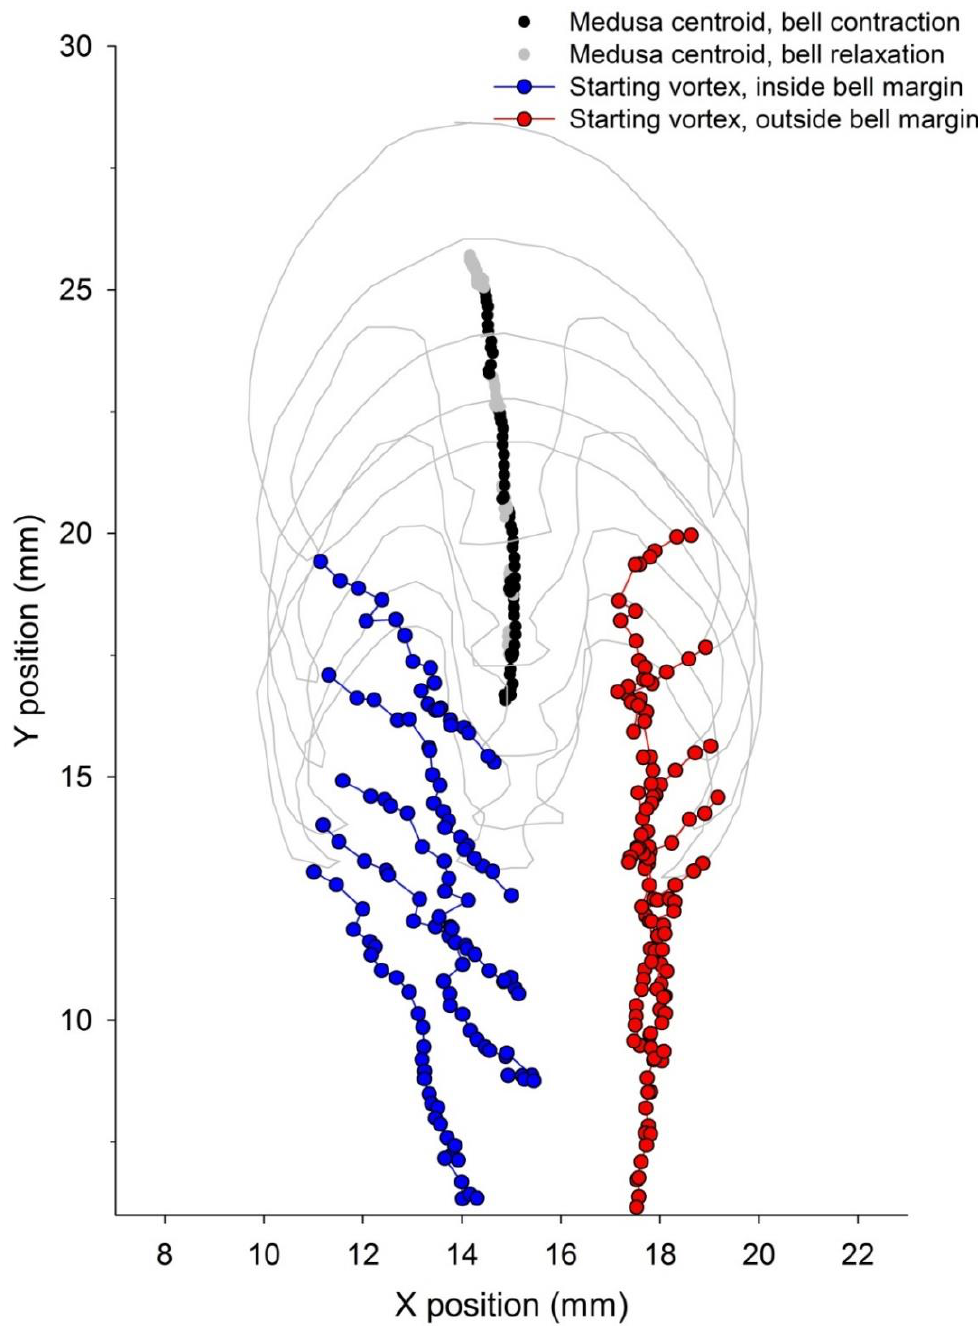
Figure 3. Paths of swimming Eutonina indicans medusa (same animal and sequence as depicted in Figure 2) and starting vortices generated in its wake. Animal outlines represent the body shape and position at the end of consecutive pulsation cycles. Centroids of the medusa body during pulsation (black—contraction phase, grey—relaxation phase) and starting vortices (red, blue) indicate the relative positions of the animal and the vortices it left in its wake during swimming. In this case, the animal’s path veered to the left during swimming and vortex pathways varied slightly from the inside (left—blue) to the outside (right—red) margins during the swimming sequence.